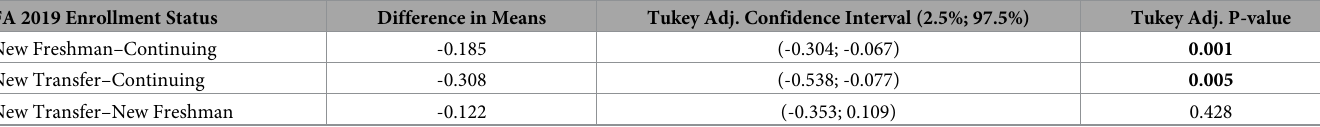
Table 3. ANOVA results for GPA change (before vs. during COVID-19) by enrollment status in FA 2019 [full sample].